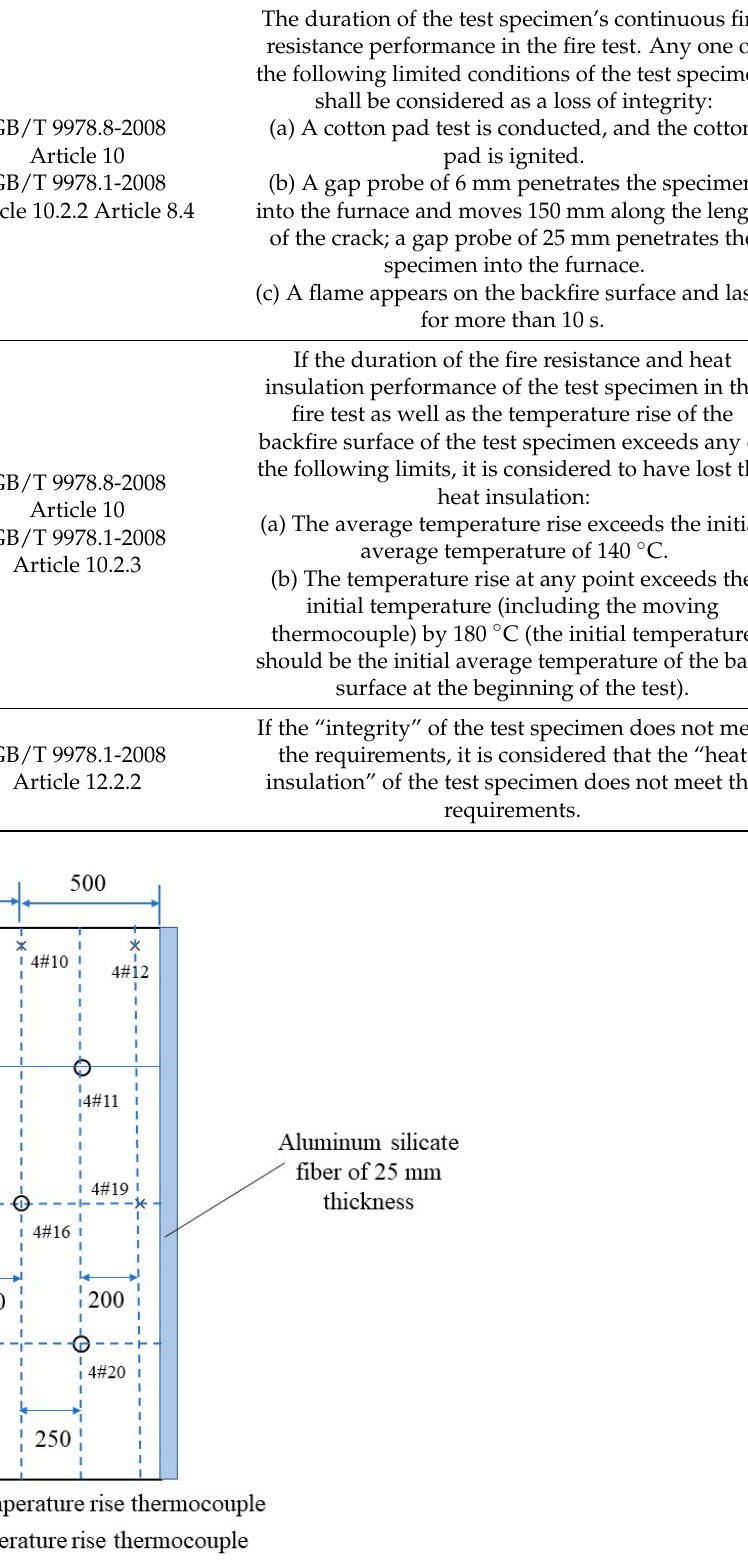
Figure 4. Schematic diagram of the measuring point layout on the backfire surface of the test specimen.